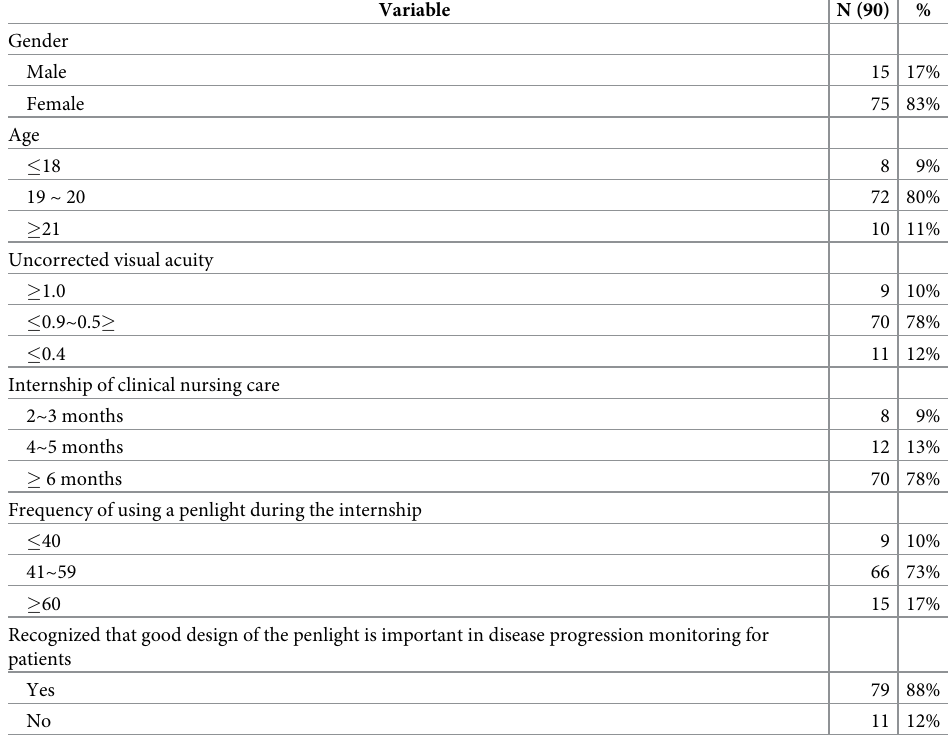
Table 1. Characteristics of the participants.